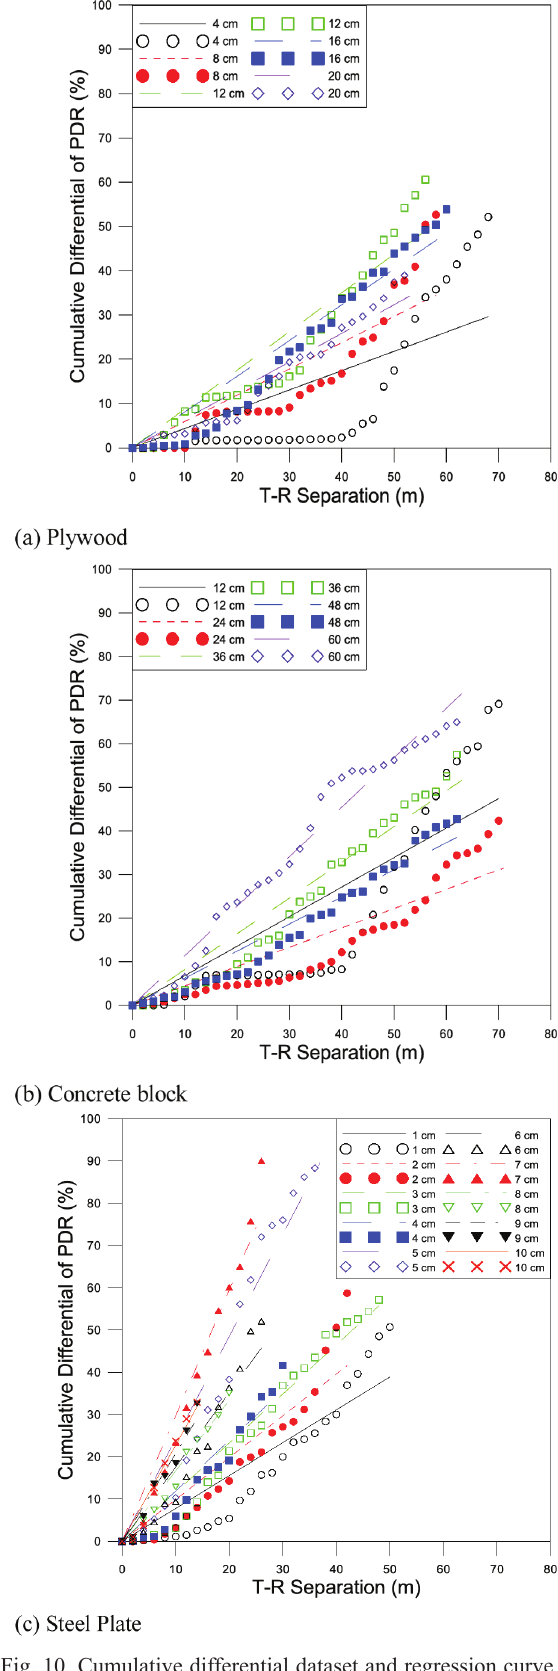
Fig. 9. Cumulative differential dataset and regression curve of LQI in an obstructed environment